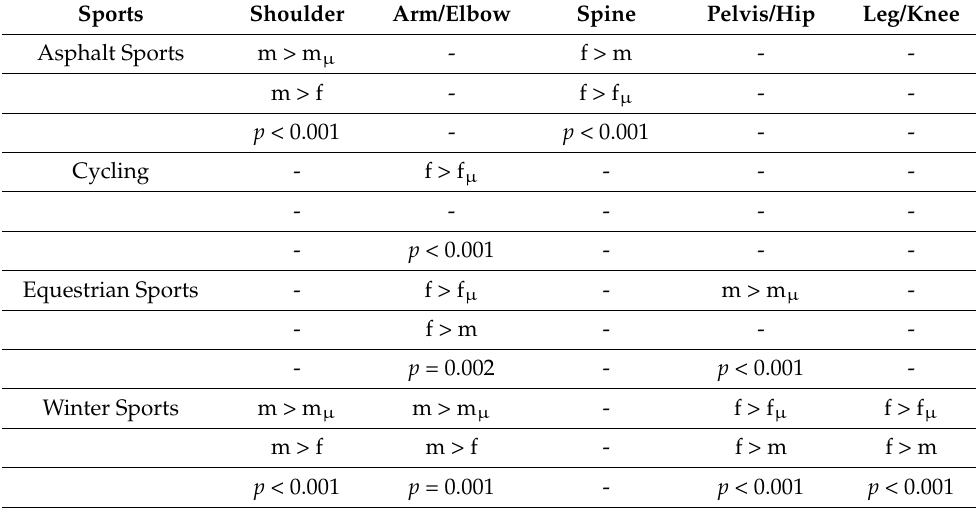
Table 3. Dependence on body region, gender and type of